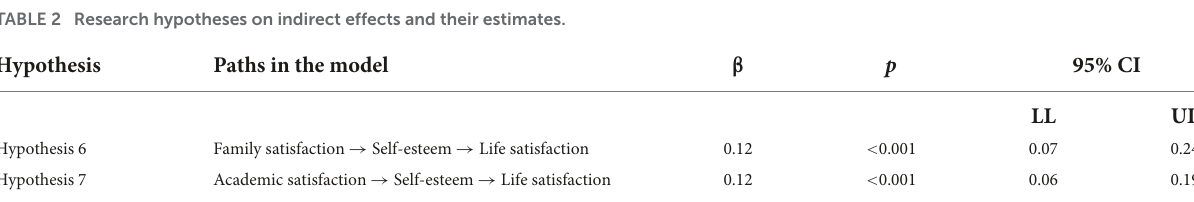
TABLE 2 Research hypotheses on indirect effects and their